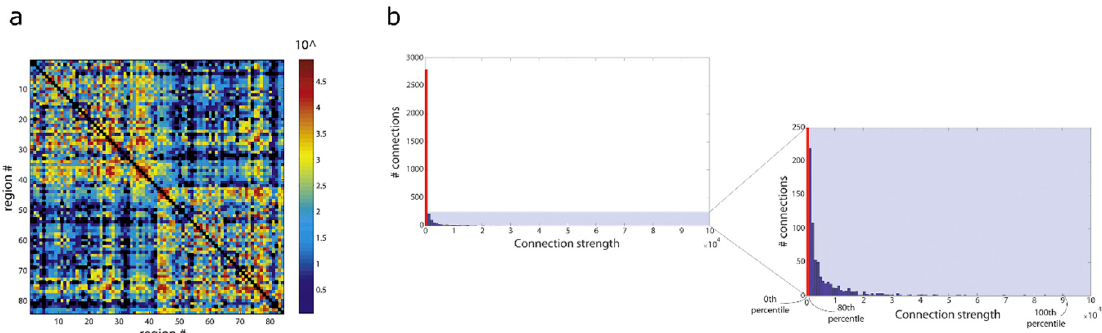
Figure 7. Illustration of the very large dynamic range in connectivity weights in the human brain connectome computed with state of the art fibre-tracking methods. Results obtained from data of the Human Connectome Project using spherical deconvolution, combined with probabilistic fibre-tracking (10 million streamlines computed with the ACT framework), and connectivity quantification using SIFT2, for the case of a 84 node parcellation. ( a ) Connectivity matrix; the colour-scale shows ~5 orders of magnitude in the dynamic range of connection strengths in this example; #: number. ( b ) Histogram of the connection strengths for all edges in the matrix from ( a ): the histogram has a long tail, with strong connections (strengths up to ~90,000) can be several orders of magnitude larger than most connections in the matrix, marked in red (~80% of connections, which have strengths < 1000. Right-most panel shows a zoomed-version of the shaded section of the full histogram. Figure modified from figures previously published in [65], with permission of Elsevier Inc, 2019.